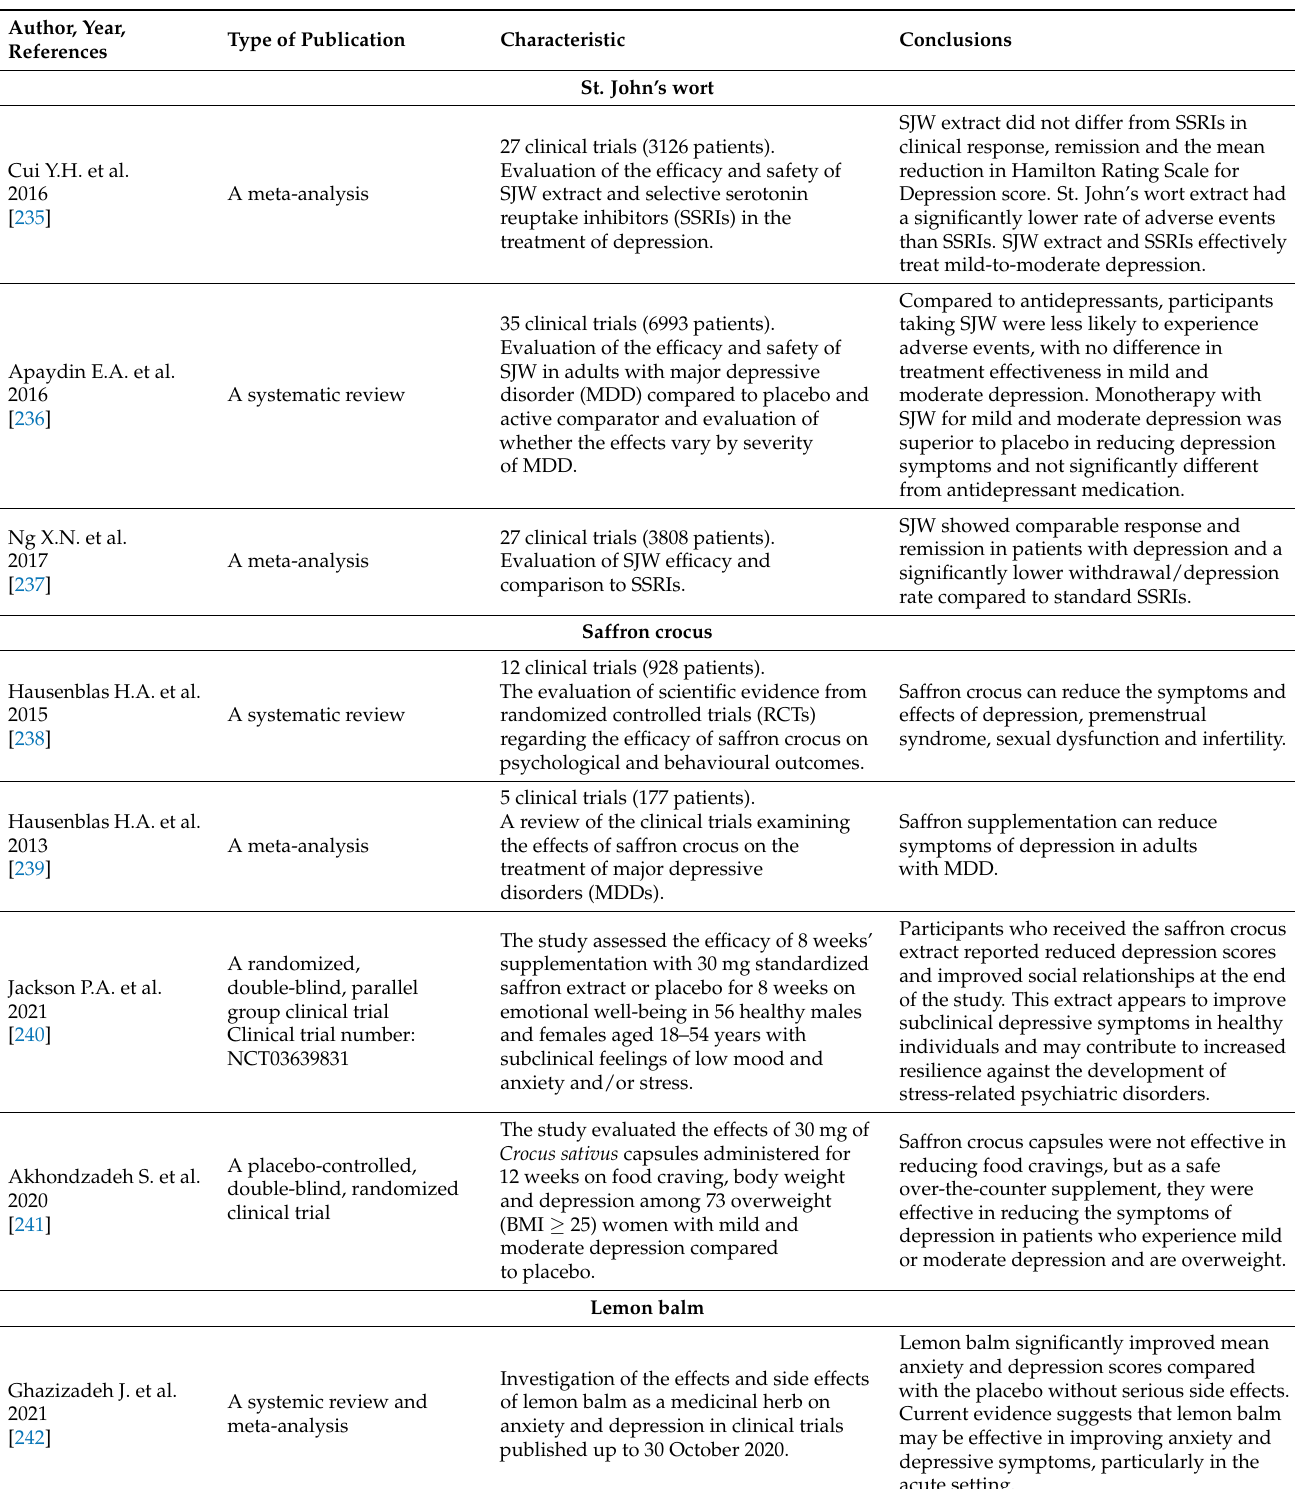
Table 5. Clinical evaluation of antidepressant activity—selected evidence from systematic reviews, meta-analyses and individual clinical